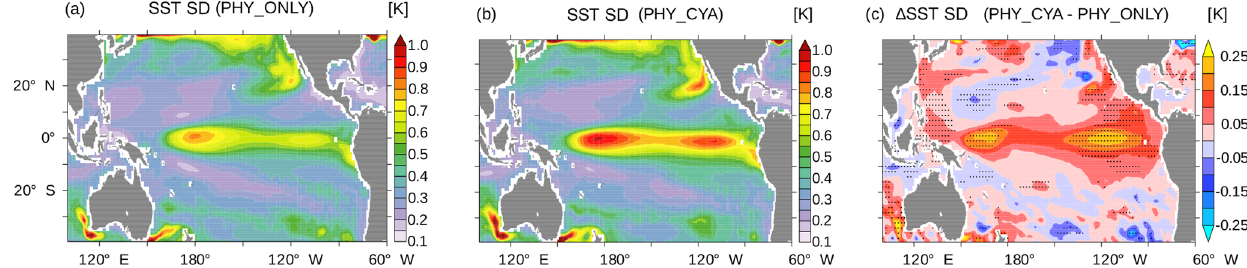
Figure 10. Standard deviation (SD) of SST (K) in the tropical Pacific in (a) PHY_ONLY and (b) PHY_CYA, and (c) the difference between PHY_CYA and PHY_ONLY. The dotted areas show anomalies larger than ± 2 times the standard deviation of eight 100-year periods of